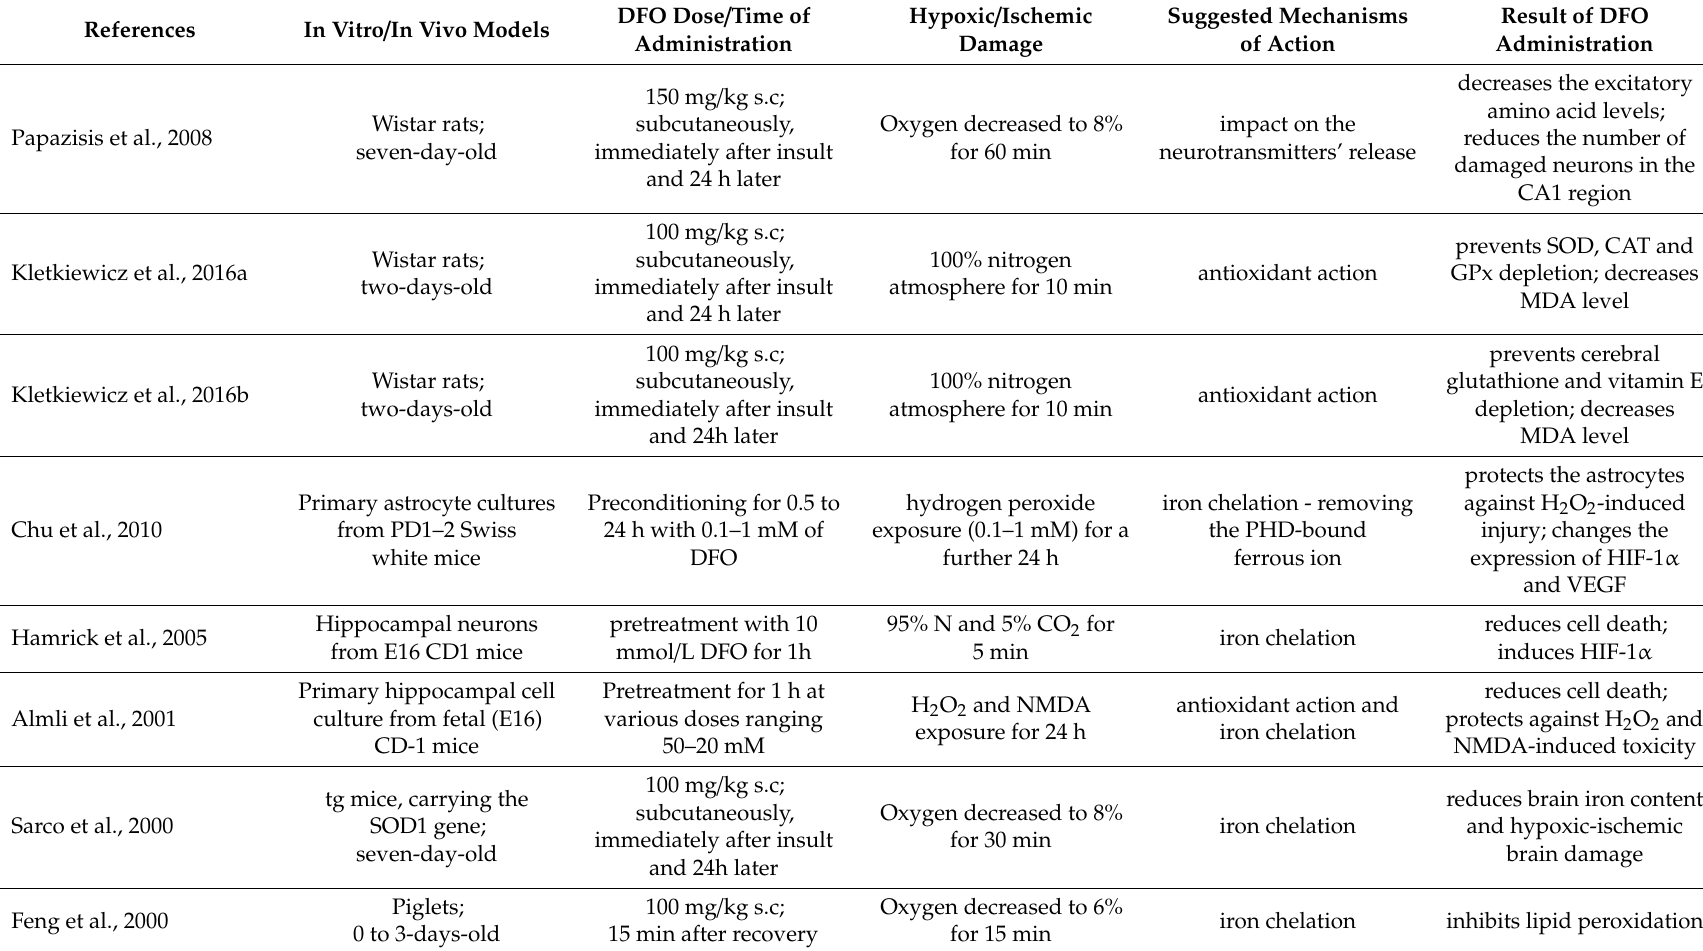
Table 2. E ff ects of deferoxamine (DFO)on brain oxidative status and other markers of brain